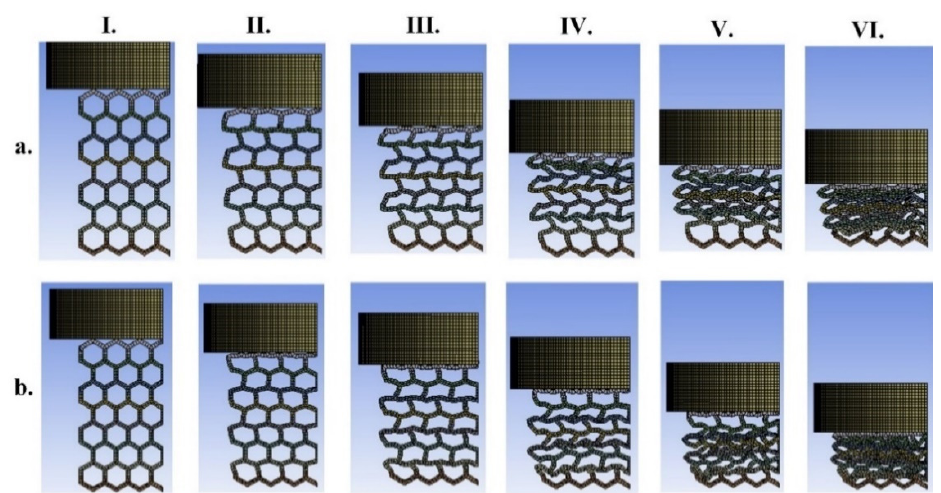
Figure 10. The current configuration of the dual-material mechanical lattice structures during loading (I to VI) for ( a ) PA12-TPC (sample 6) and ( b ) TPC-PA12 (sample 7) (see Figure 2 for the difference between the two samples). Note that applied displacement in I to VI are increased from 0.0033 to 0.02 m, with a displacement increment of 0.00334 m.